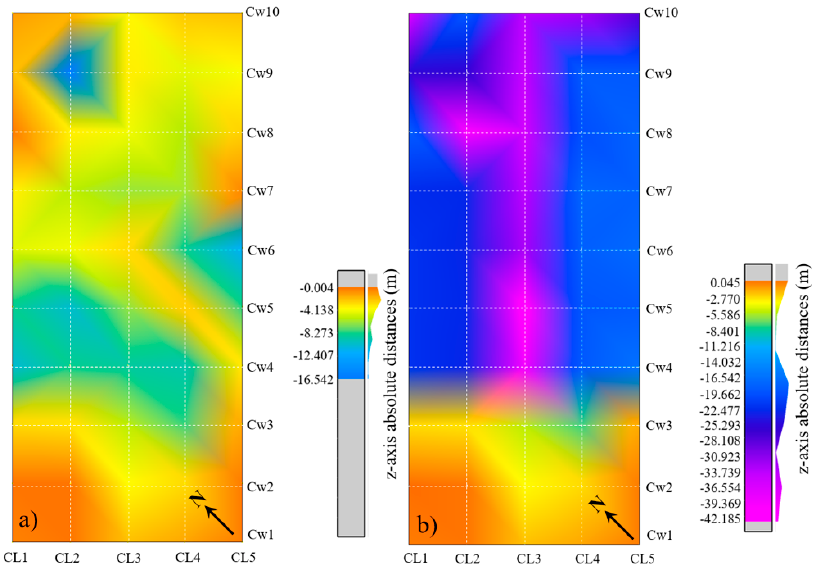
Figure 20. Centroid data C2C comparison along z-axis: ( a ) Initial epoch point cloud compared to consolidation prognosis mesh, ( b ) initial epoch point cloud compared to total subsidence (75%) mesh.